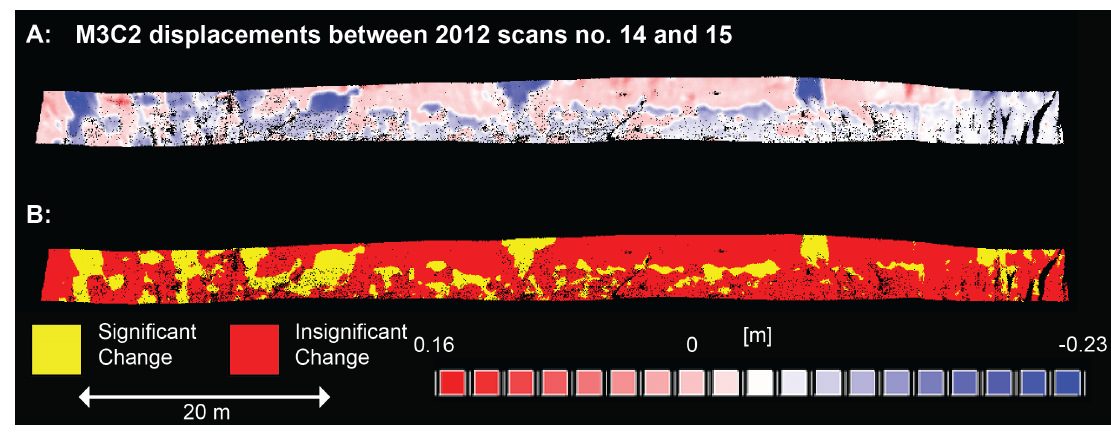
Figure 5. ( A ) Example of a section of a point cloud colored by change from the previous epoch using the M3C2 algorithm [22]. Note that headwall retreat is highly spatially variable, but that most of the wall during a 12 h period does not experience significant